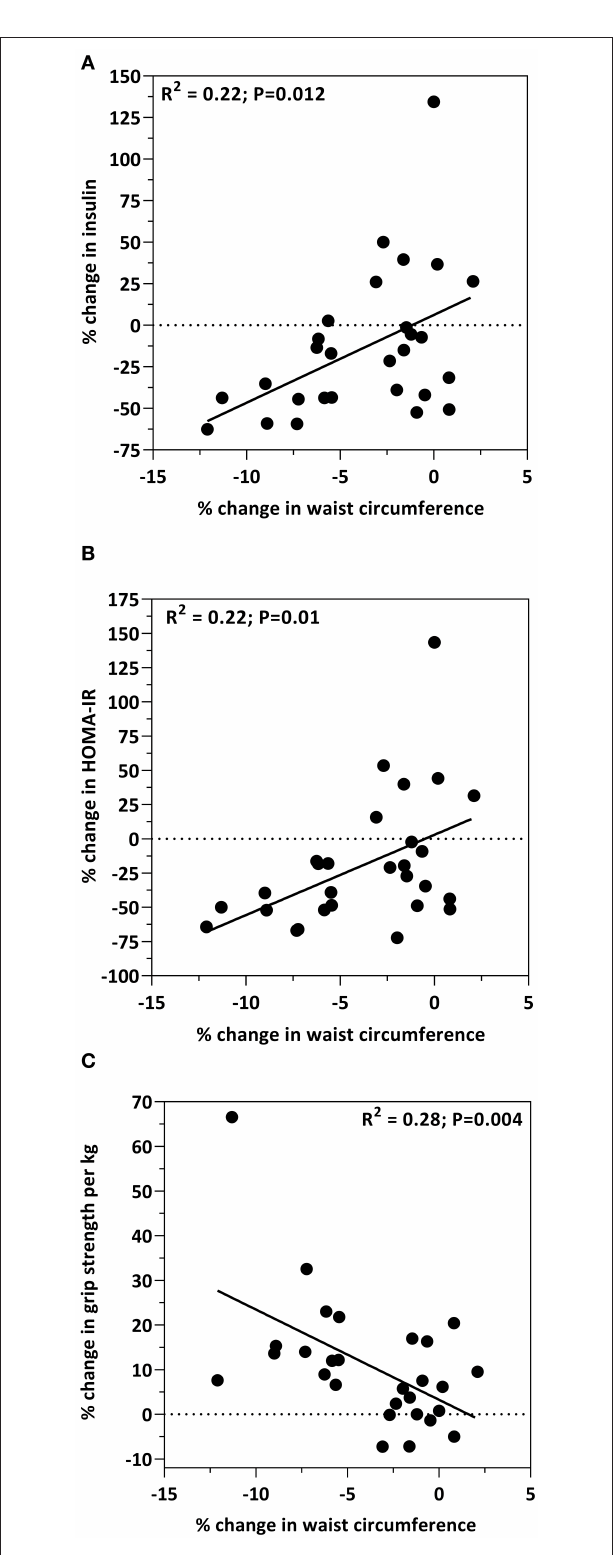
FIGURE 1 | Bivariate correlations between the percent change from baseline in waist circumference and the percent change from baseline in insulin levels (A) , HOMA-IR (B) and grip strength (C)